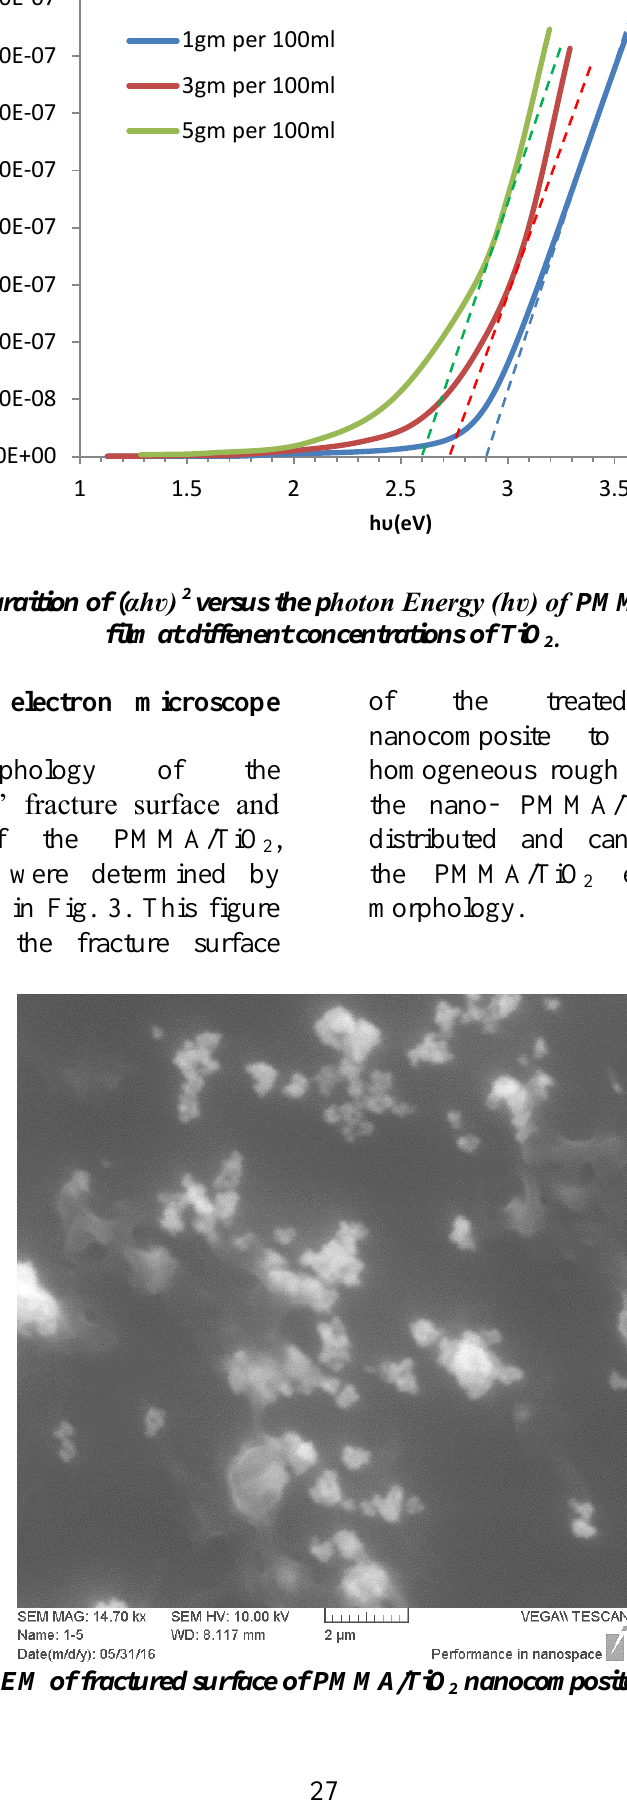
nanocomposite thin 2